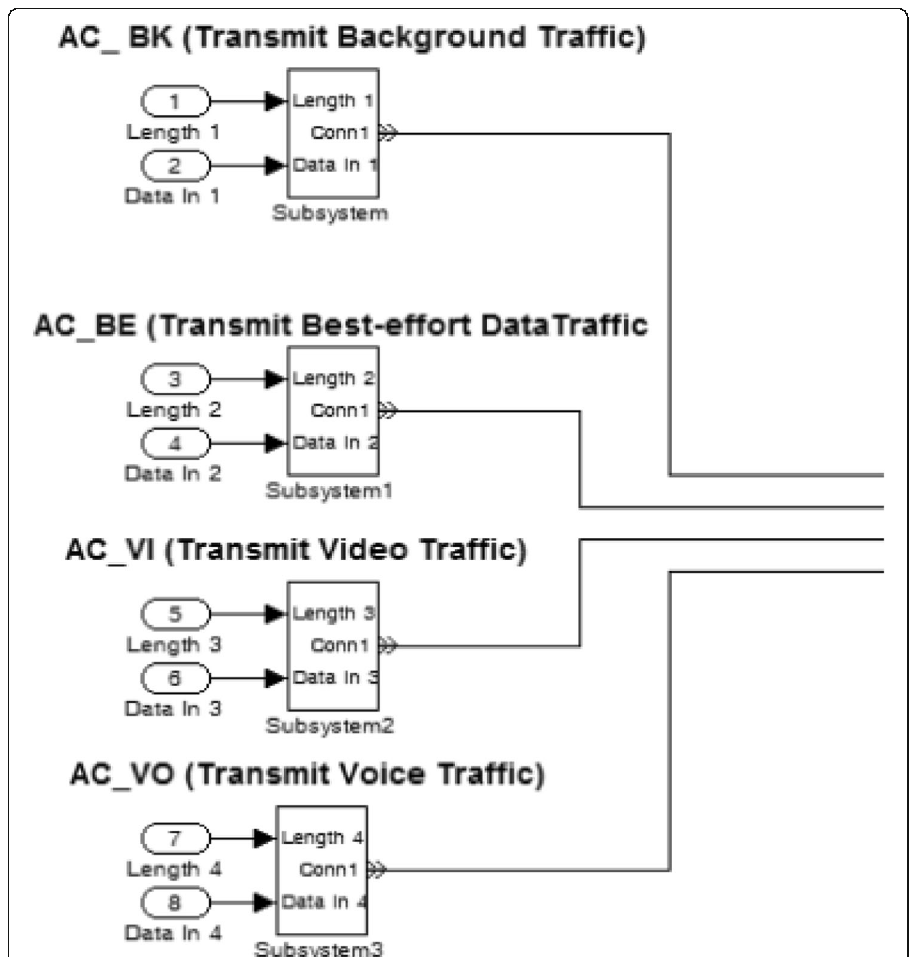
Fig. 6 Snapshot of four traffic sources (subsystems) as implemented in MATLAB Simevent model